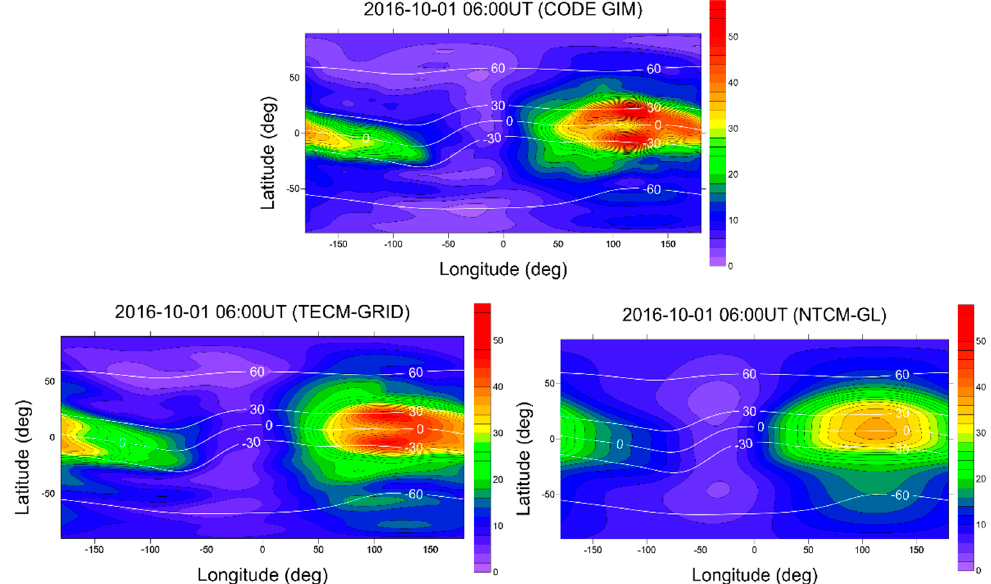
Figure 11. Comparison of TECM-GRID and NTCM-GL with the CODE GIM (1 August 2016).